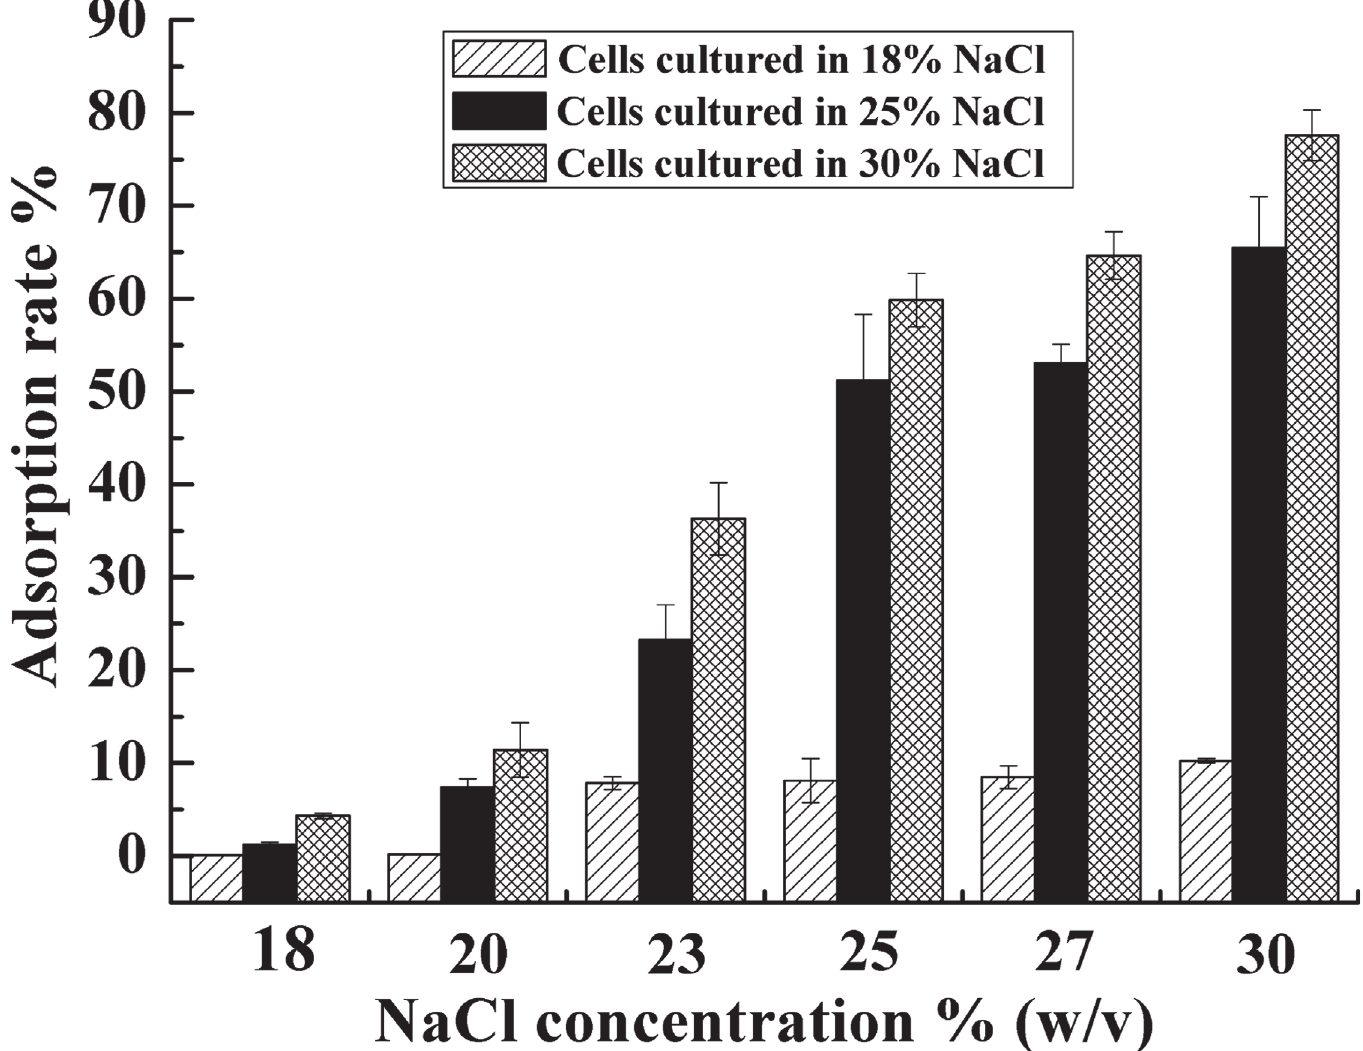
Fig 2. Adsorption efficiency of SNJ1 under different salt